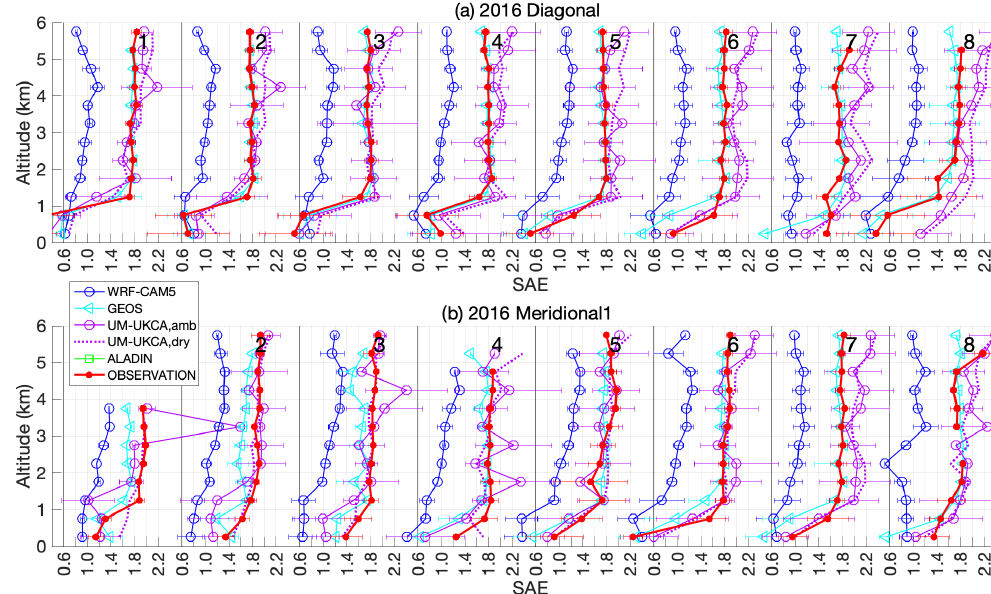
Figure 19. As in Fig. 16 but for the scattering Ångström exponent (SAE).